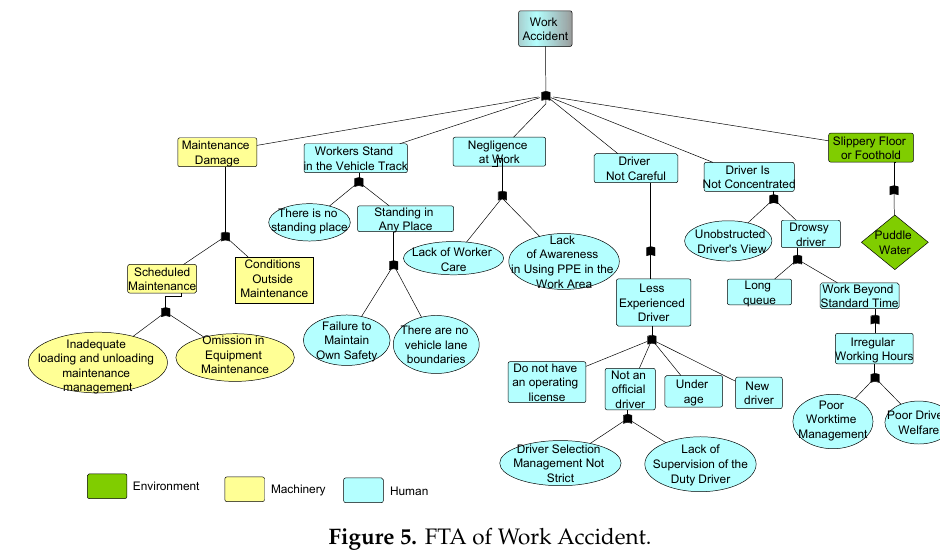
Figure 5. FTA of Work Accident.